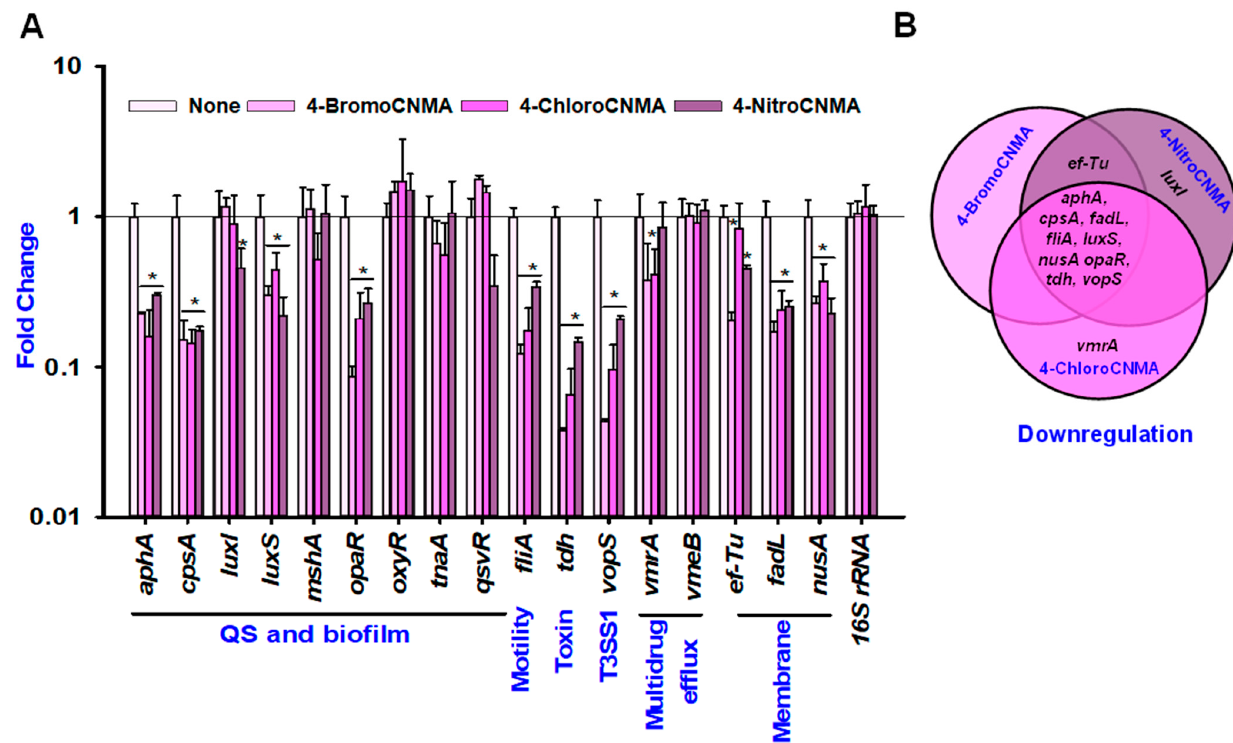
Figure 6. Transcriptional profiles of V. parahaemolyticus treated with or without 4-BromoCNMA, 4-ChloroCNMA, and 4-NitroCNMA. Relative expressions represent transcriptional levels after treatment with the CNMA derivatives at 50 µg/mL compared to non-treated controls ( A ). The bars represent the mean ± SDs of two independent cultures performed in triplicate. The 16S rRNA gene was used as a housekeeping gene. The Venn diagram represents the downregulation of genes by the CNMA derivatives ( B ). * denotes a significant difference at p < 0.05.